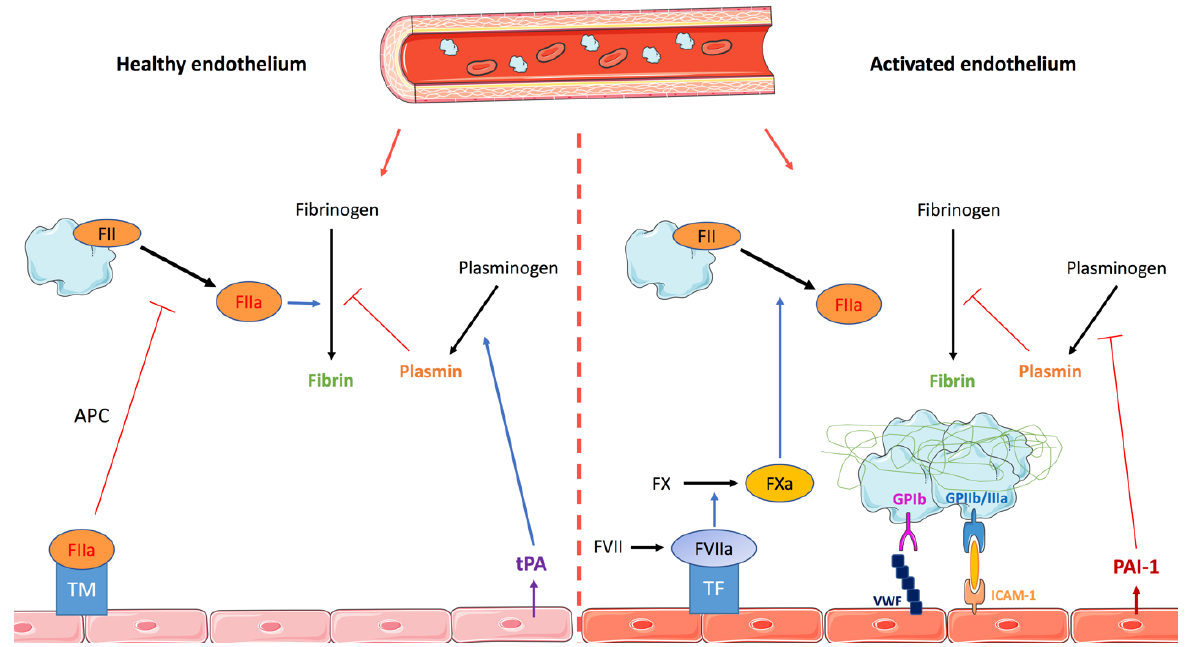
Figure 3. Overview of the coagulation cascade initiated by endothelial tissue